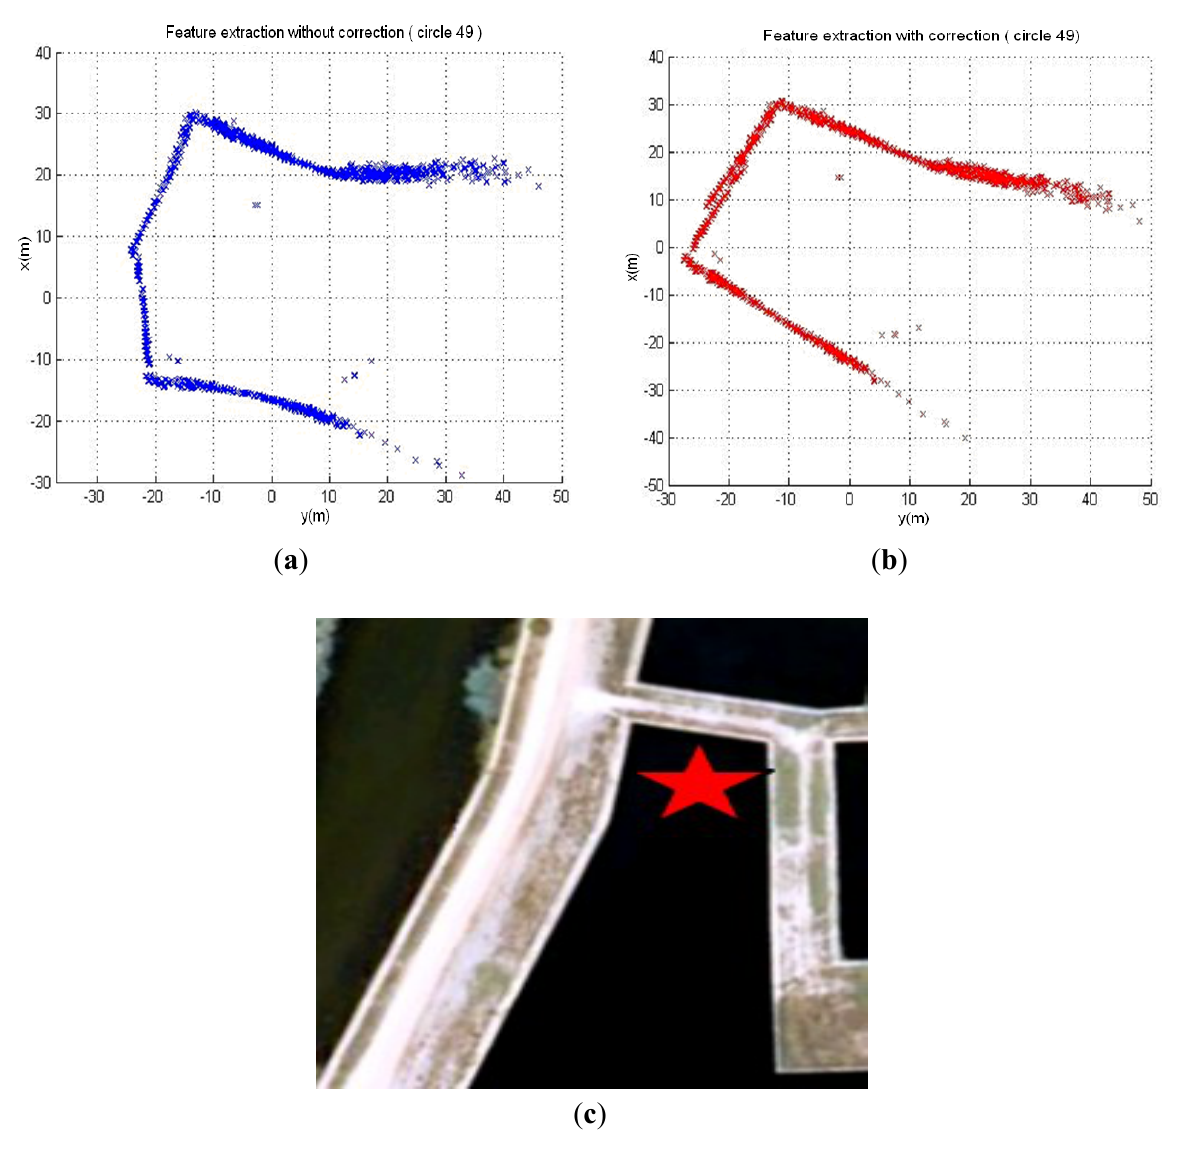
Figure 3. Effect of the vehicle motion on acoustic images. ( a ) Raw sonar image; ( b ) Corrected sonar image; ( c ) Zenithal view of the Abandoned